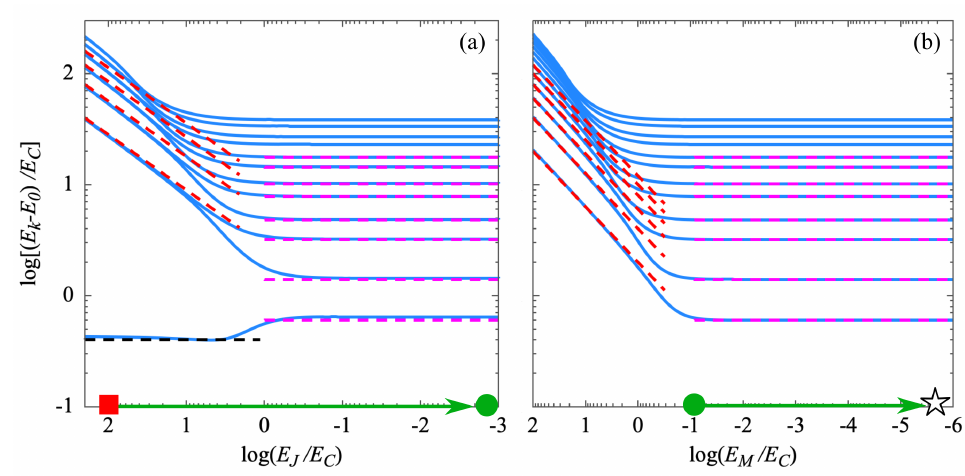
Figure 5: Excitation energies during the reference protocol. Parameters are the same as in Fig.